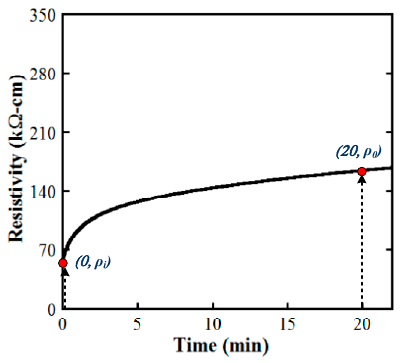
Figure 7. Representative electrical polarization response of cement-based composites.